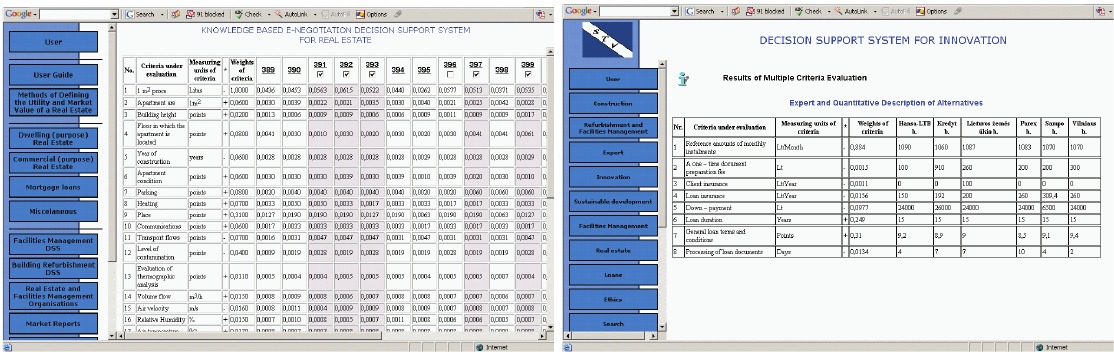
Figure 4. selection of real estate objects for automated negotiations ( left ) and analysis of loan alternatives offered by certain banks ( right